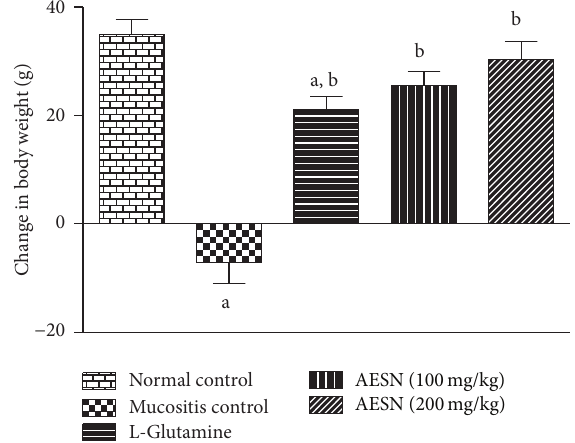
Figure 2: Body weight changes in busulfan and radiation induced oralmucositis.Bodyweightchangeineachgroupwasrecordedfrom day 1 to day 15. All values are expressed as mean ± SEM of 6 animals. a 𝑃 < 0.05 versus normal control, b 𝑃 < 0.05 versus mucositis control.